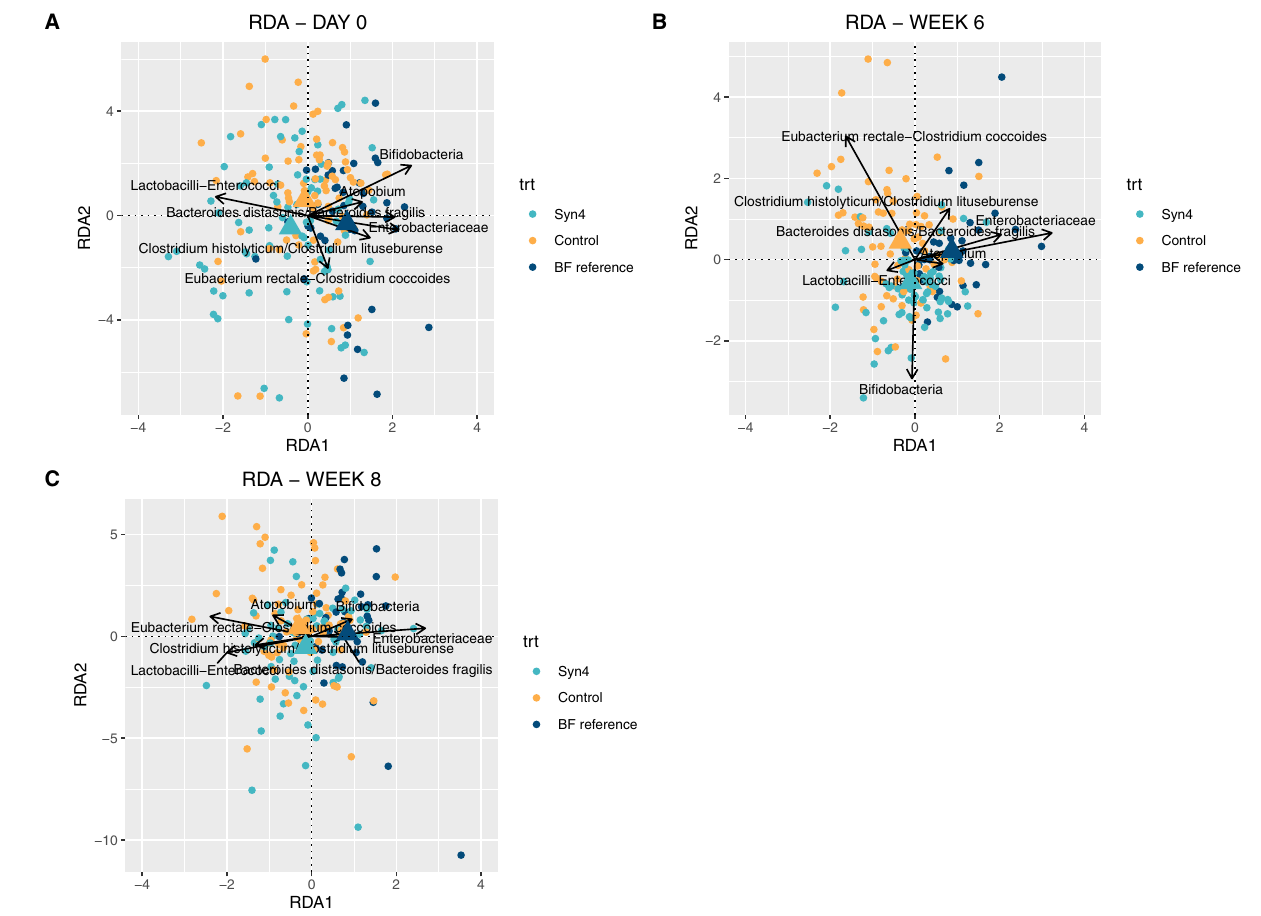
Figure 6. RDA plot for gut microbiota analysis by treatment (control, syn4 and reference) at baseline ( A ), Week 6 ( B ) and Week 8 ( C ). A dot represents each sample and different colors represent different treatment (trt) groups. Triangles indicate centroids of study groups. Statistical significance of differences between groups based on the resulting model was evaluated using an ANOVA like permutation